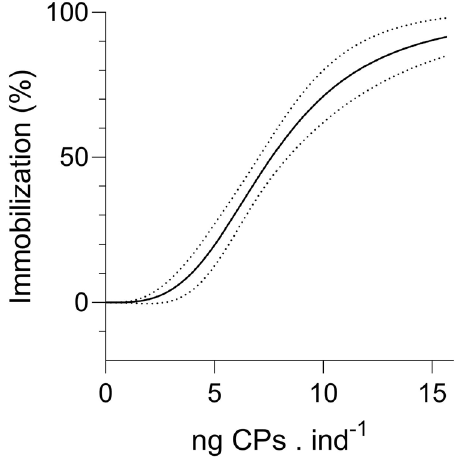
Figure 3. Dose-response curve for D. magna with increasing body burden of CPs (ng CPs per individual) dosed via liposomes ( = . R 2 = 0.77, Supplementary Table S7). Groups of 10 Immobilization ; 100 − 1 + − 1 10 logLD ng CPsind 50 individuals (n = 3) were exposed to increasing doses of CPs via liposomes at a constant liposome concentration of 0.5 × 10 5 liposomes mL − 1 . 95% confidence intervals of the curve are